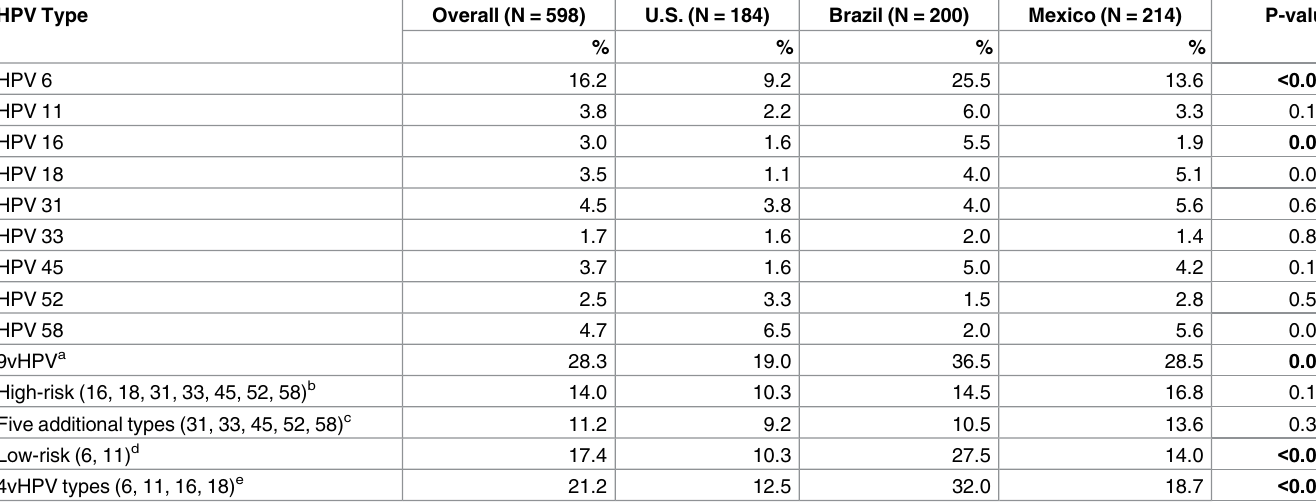
Table 2. Grouped and type-specific seroprevalence of 9vHPV types among men from Brazil, Mexico and the United States HPV